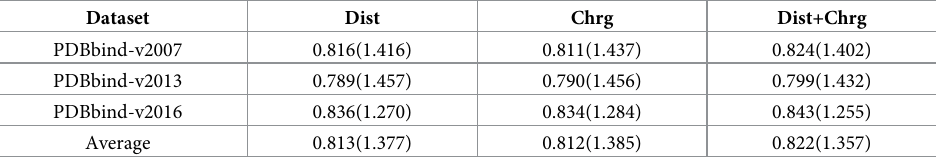
Table 3. The PCCs and RMSEs ( pK d / pK i ) for our DC-GBT models in three test cases, i.e., PDBbind-v2007, PDBbind-v2013 and PDBbind-v2016. Three DC-GBT models are considered with features from different types of bipartite graphs. The DC-GBT(Dist) model uses features from distance-based bipartite graphs; The DC-GBT(Chrg) model uses features from electrostatic-based bipartite graphs; The DC-GBT(Dist+Chrg) model uses features from both distance-based bipartite graphs and electrostatic-based bipartite